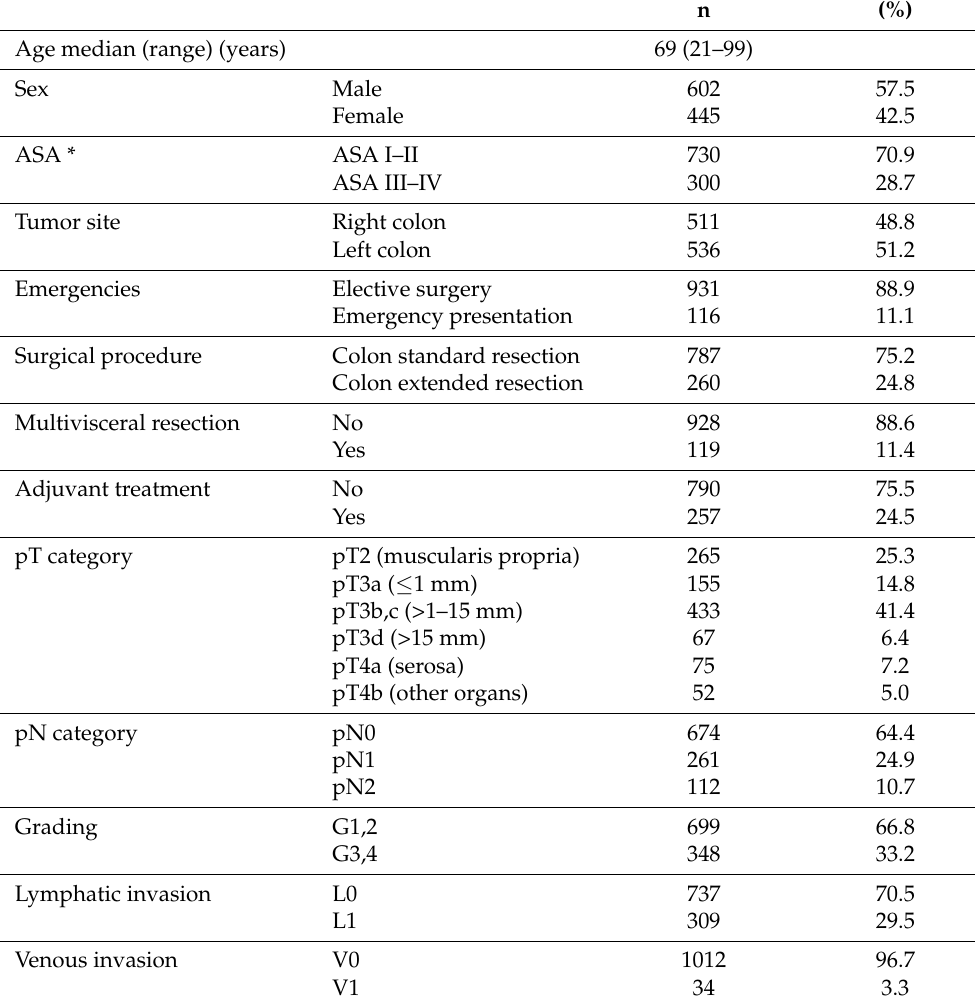
Table 1. Patient and tumor characteristics for 1047